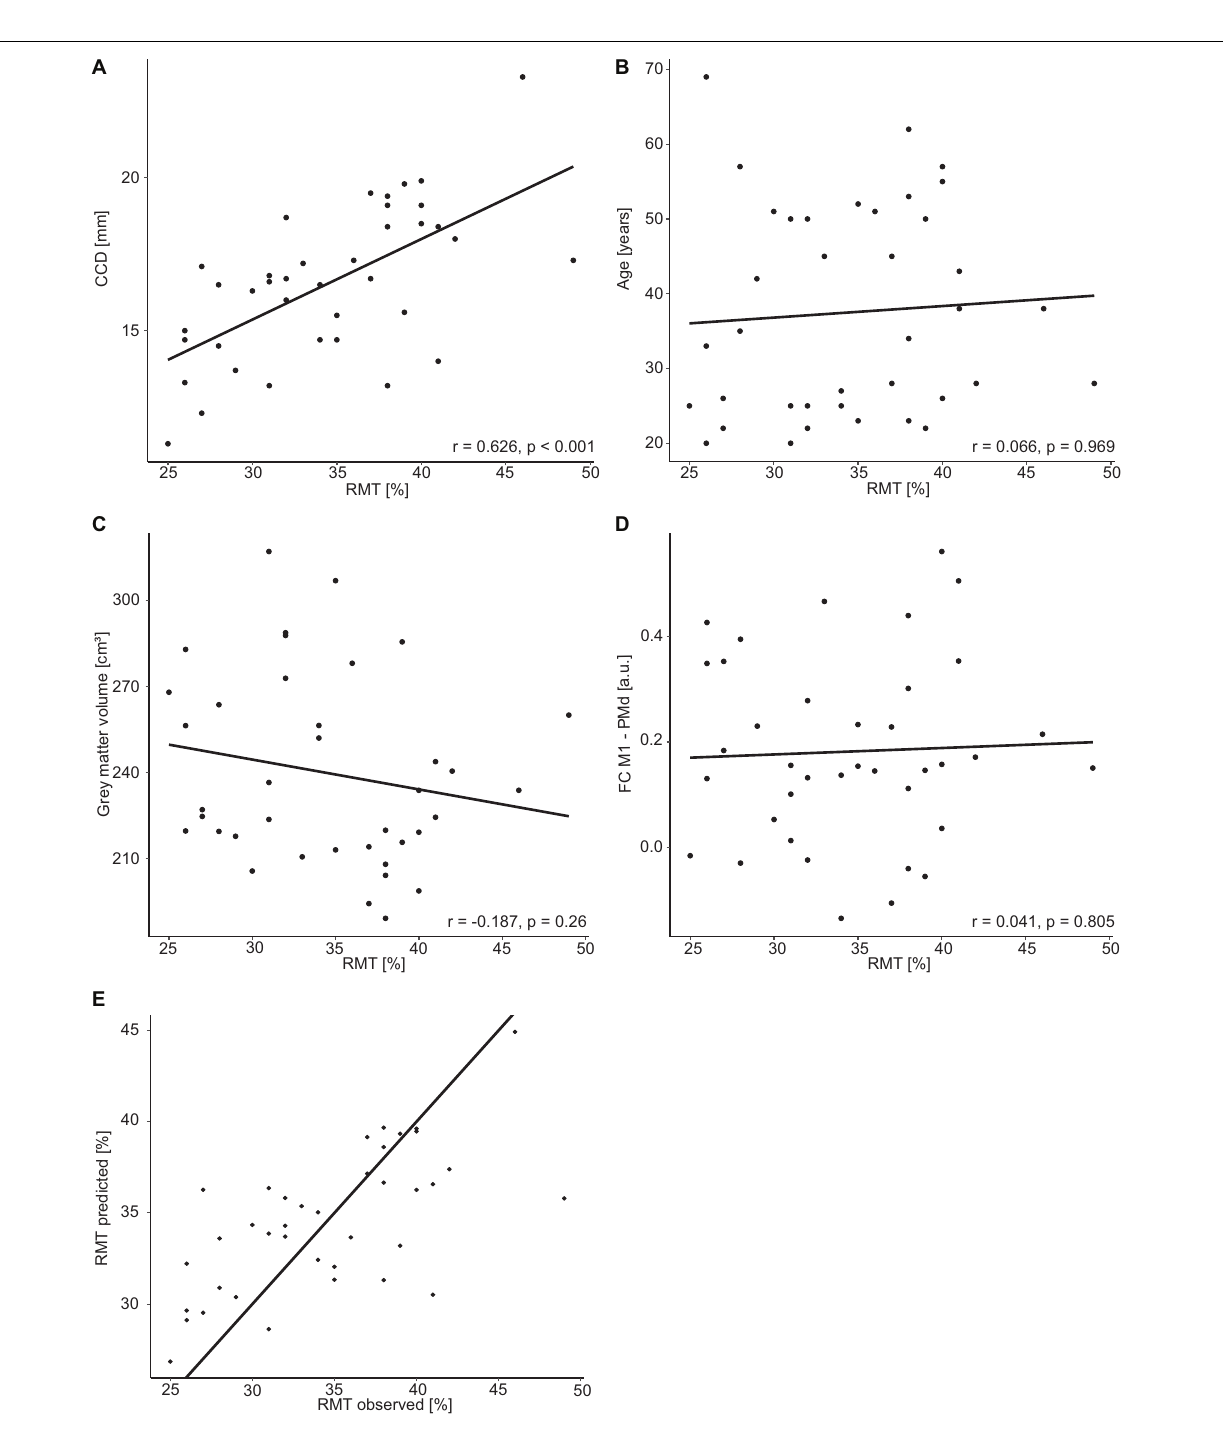
FC M1–PMd estimated here was also positive and thus in the opposite direction compared with Rosso et al.